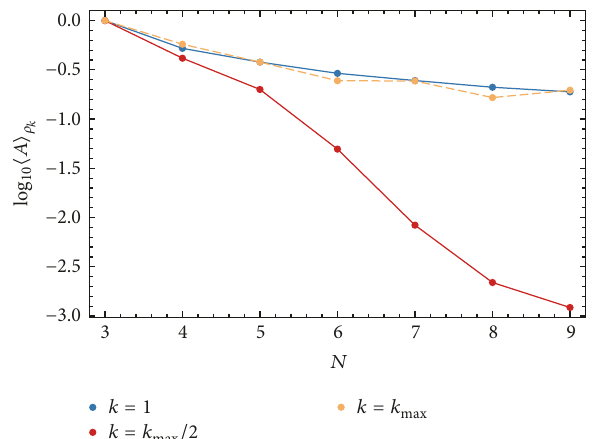
Figure 5: Scaling in rank stability . Scaling of the average value of the area for which a change in position will not change the rank of a trajectory, for ranks 𝑘 = 1 , 𝑘 max /2 , and 𝑘 max and for different system